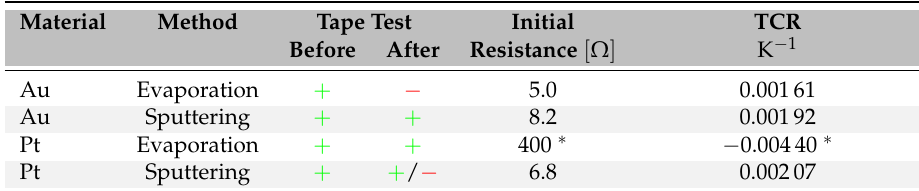
Table 4. Results of the Scotch tape metal adhesion tests before and after heat cycling. Here, + means passing the tape test, − means failing the tape test, and + / − means that not all test structures failed the tape